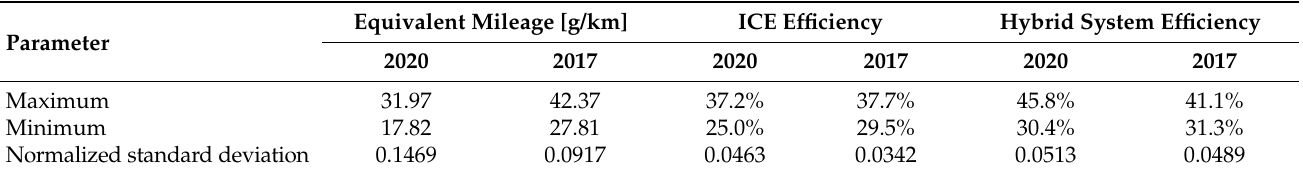
Table 5. Maximum values, minimum values and normalized standard deviation of the parameter values for the energy analysis of the